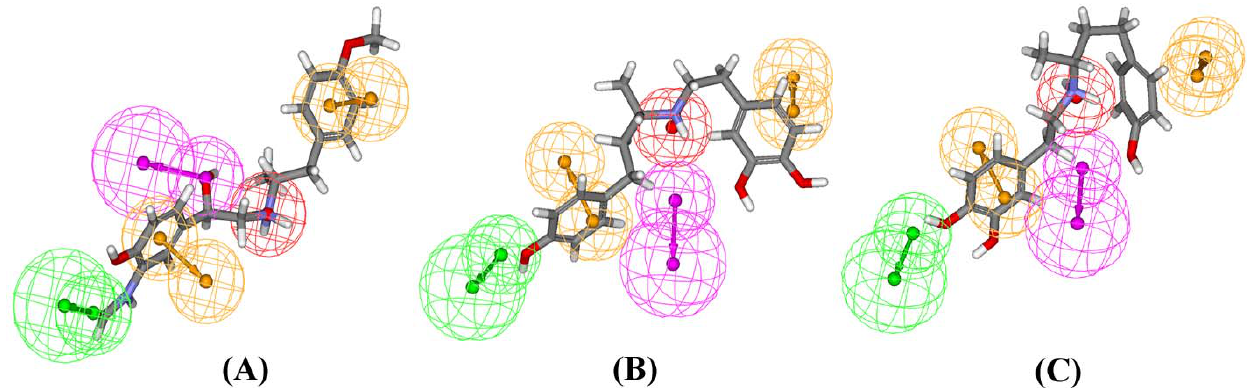
Figure 3. Hypol_I aligned with arformoterol (A), ( S )-dobutamine (B) and ( R )-dobutamine